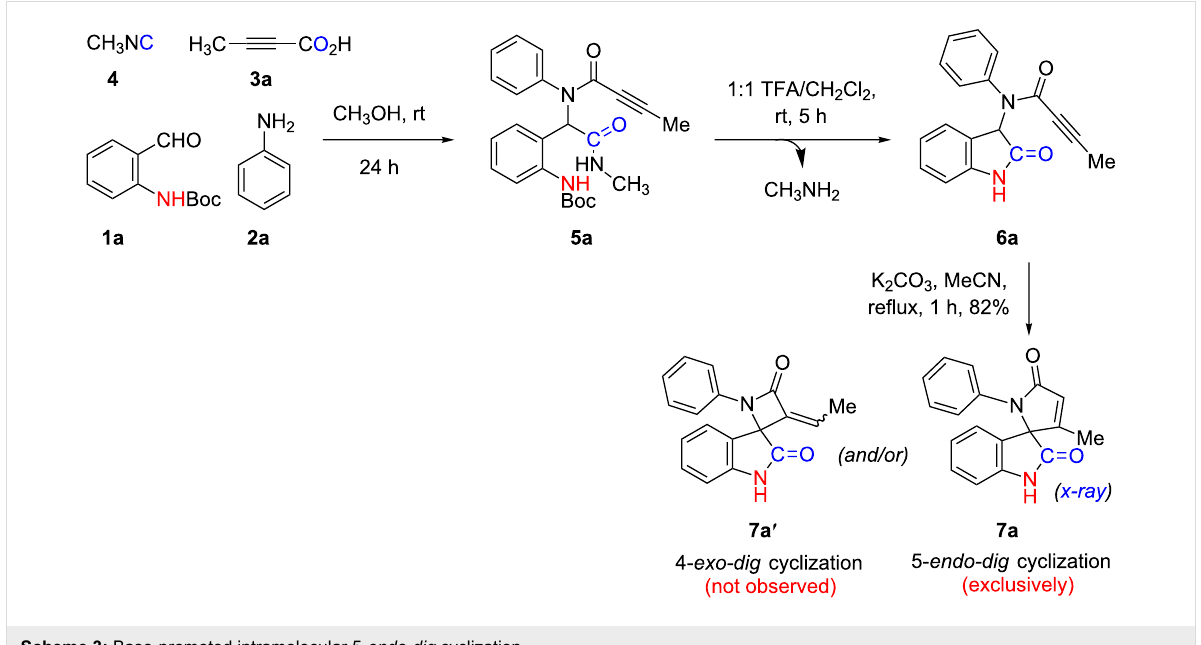
Scheme 3: Base-promoted intramolecular 5- endo-dig